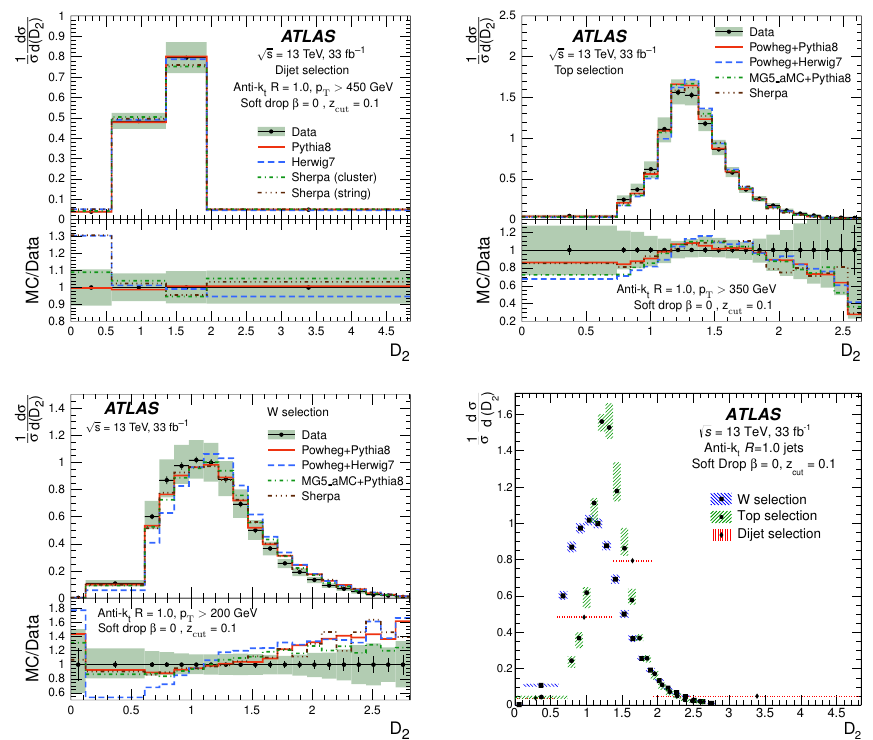
Figure 6 . The distributions of D 2 compared with different MC predictions for soft-dropped large- radius jets from dijet (top left), top (top right), and W (bottom left) selections. For the dijet selection, Sherpa is tested with two different hadronisation models. Data are compared between the soft-dropped large-radius jets for the three selections mentioned above (bottom right). The shaded bands represent the total uncertainty, while the error bars show the statistical uncertainty, except in the bottom right plot, where the shaded areas represent the total